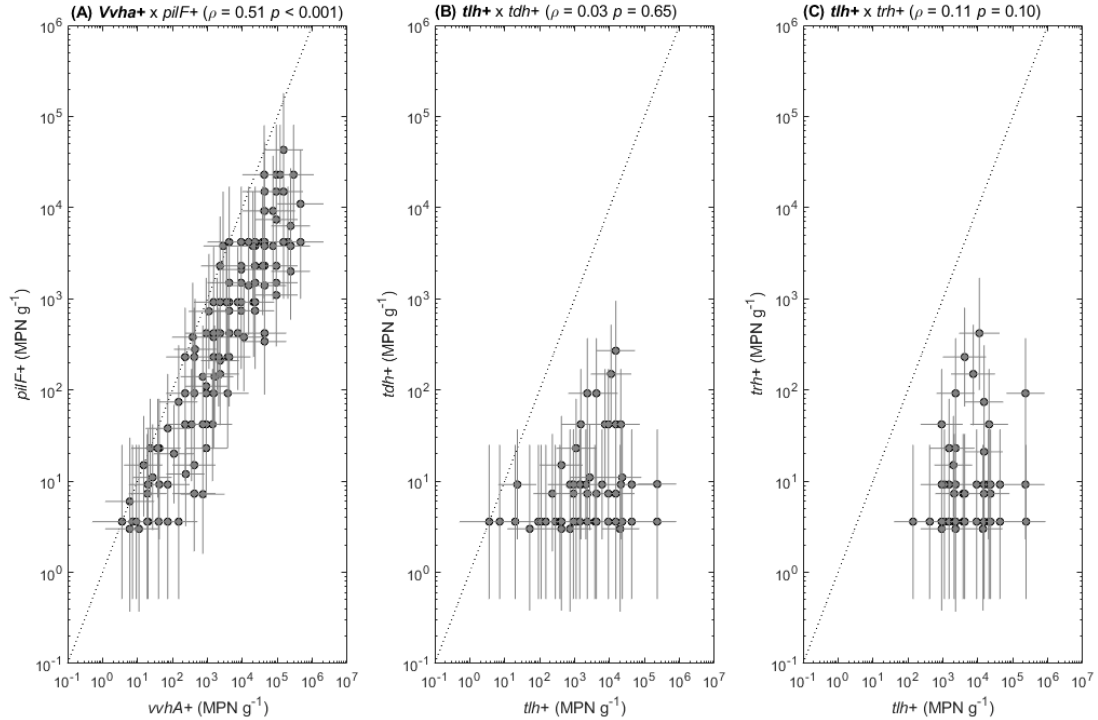
Figure 5. Pearson’s correlations between ( A ) concentrations of total ( vvhA +) and pathogenic ( pilF +) V. vulnificus , ( B ) concentrations of total ( tlh +) and pathogenic V. parahaemolyticus tdh +, and ( C ) con- centrations of total ( tlh +) and pathogenic V. parahaemolyticus trh + measured during both years of the study in oyster samples. The dashed lines illustrate a 1:1 identity line.